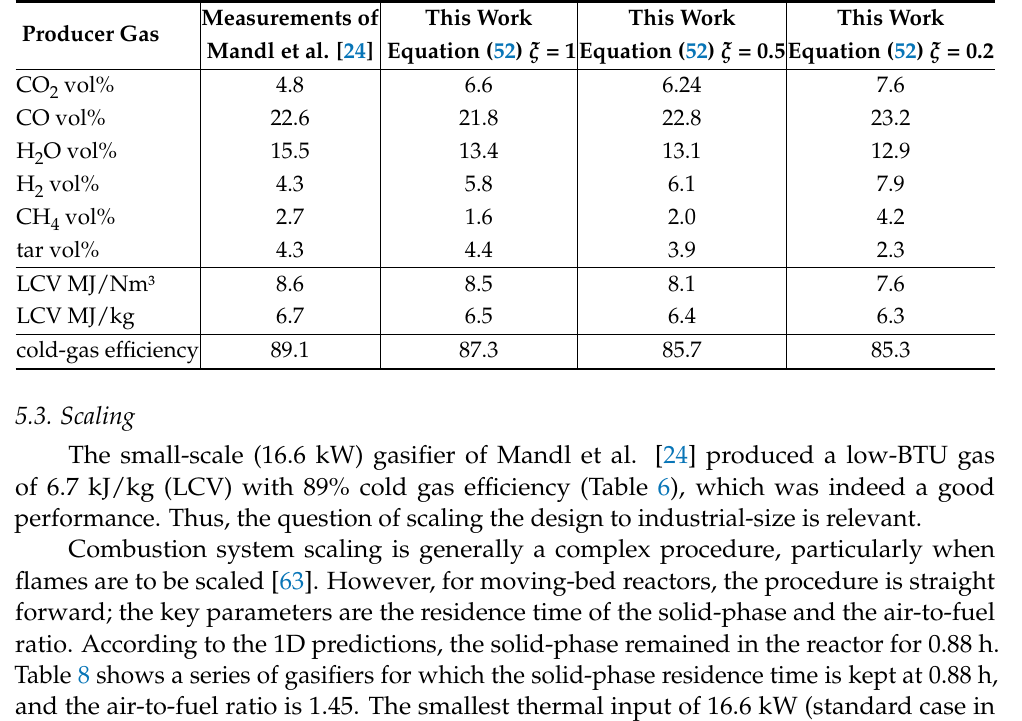
Figure 8. Influence of the correction factor ξ on the solid- and gas-phase temperatures ( Top ) ξ = 1, ( Middle ) ξ = 0.5 and ( Bottom ) ξ = 0.2. The moving pyrolysis zone is highlighted in red. Table 7. The influence of the correction factor ξ on the predicted composition and LCV of the producer-gas as well as on cold-gas